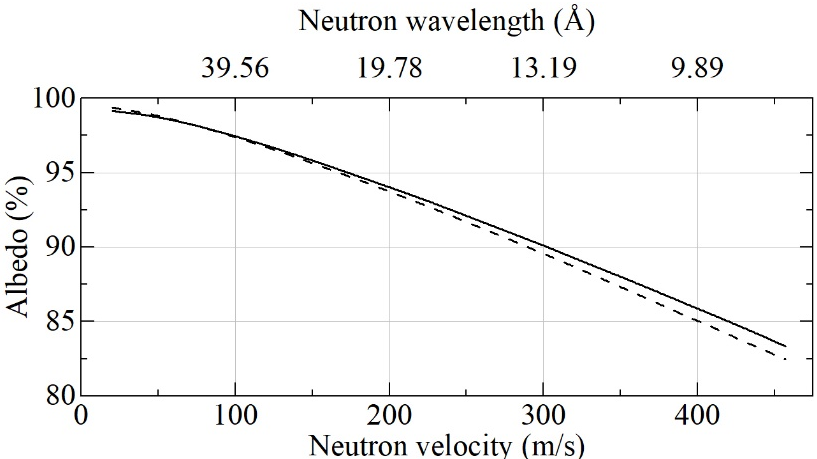
Figure 6. Neutron albedo for the flat semi-infinite media of DF-DNDs (dashed lines) and S-DNDs (solid lines) versus neutron velocity and wavelength.